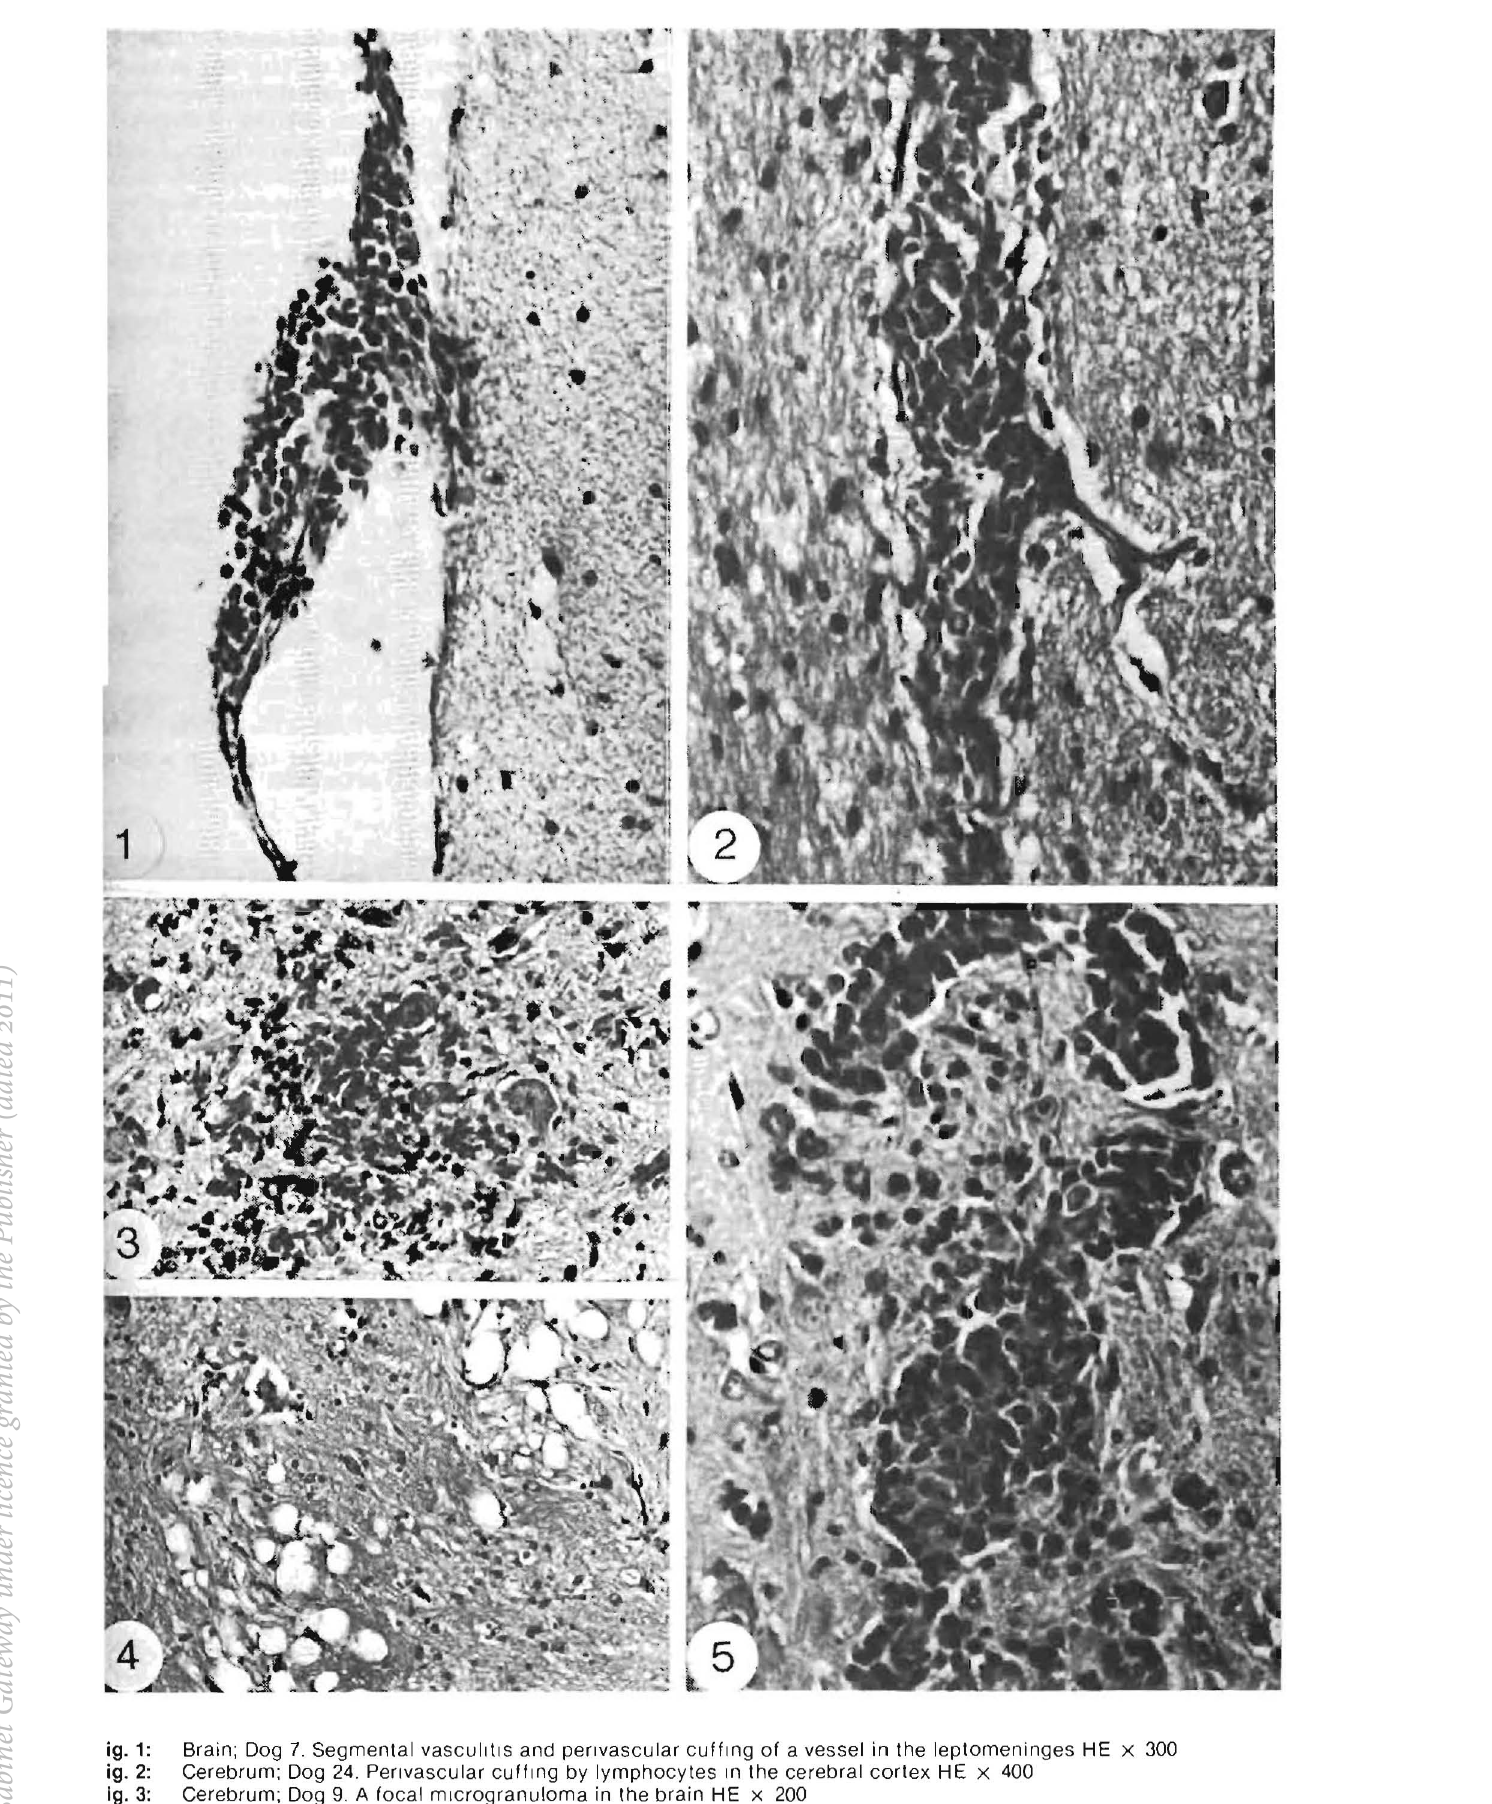
ig.1: Brain; Dog 7. Segmental vasculitis and perivascular cuffing of a vessel in the leptomeninges HE x 300 ig. 2: Cerebrum; Dog 24. Perivascular cuffing by lymphocytes In the cerebral cortex HE x 400 Ig.3: Cerebrum; Dog 9. A focal mlcrogranuloma in the brain HE x 200 ·ig.4: Cerebellar peduncle; Dog 7. Areas of status spongiosis In the white matter HE x 150 ·ig.5: Brain; Dog 24. Perivascular hypertrophy of pericytes and a granulomatous perivasculitis in the brain HE x 400